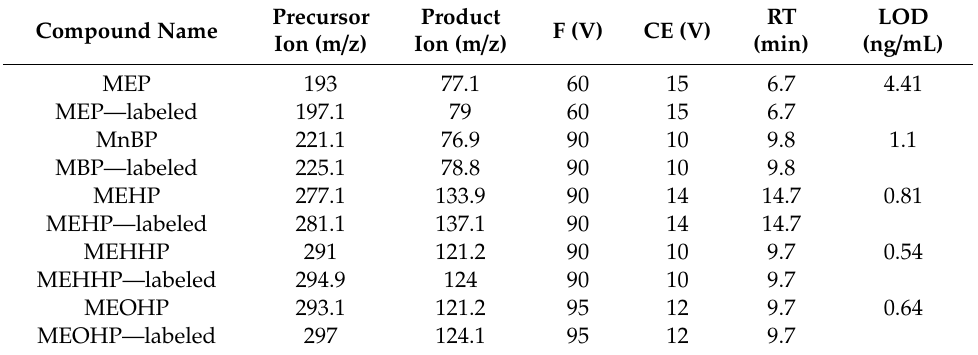
Table 1. Phthalate monoesters: Chromatographic and mass spectrometric